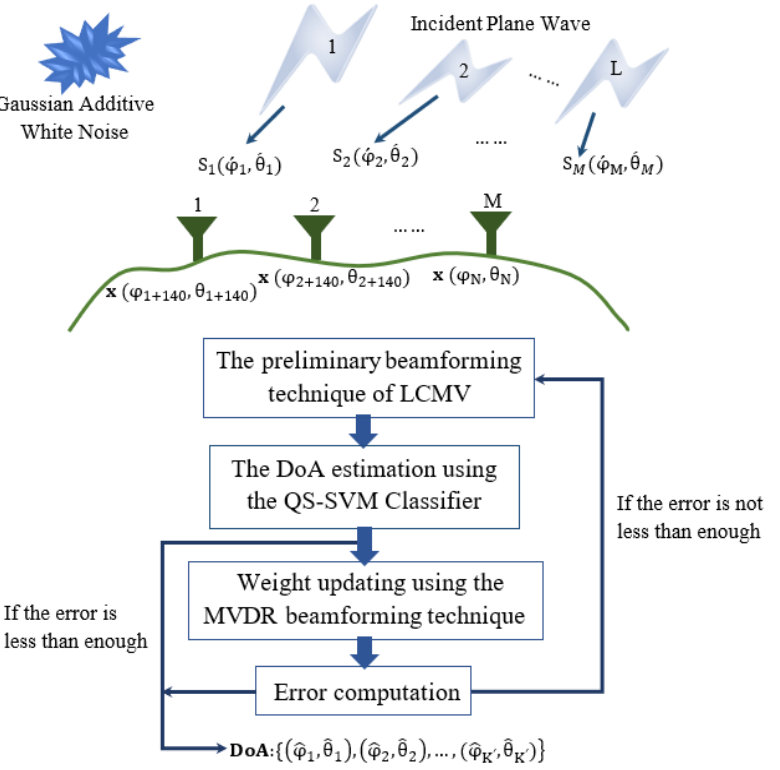
Figure 2. Procedures for the DoA estimation using the QS-SVM-based digital beamformer. It is assumed that there are M numbers of the proposed hybrid array antennas in Figure 1b of [7]. Each hybrid antenna array consists of 140 elements whose outputs have been measured. The proposed QS-SVM algorithm for the DoA estimation measures outputs of N array elements and predicts the directions of L signals impinging on the array elements. In this figure, position vectors are supposed to be in a two-dimensional plane of θ and φ . The process of the DoA estimation is to monitor the N outputs of antenna elements and predict the angle of arrival of L signals, l = 1,2, . . . , L . N = M × 140. M = 5 in this work. K (cid:48) denotes a number of sources that we can obtain after the DoA